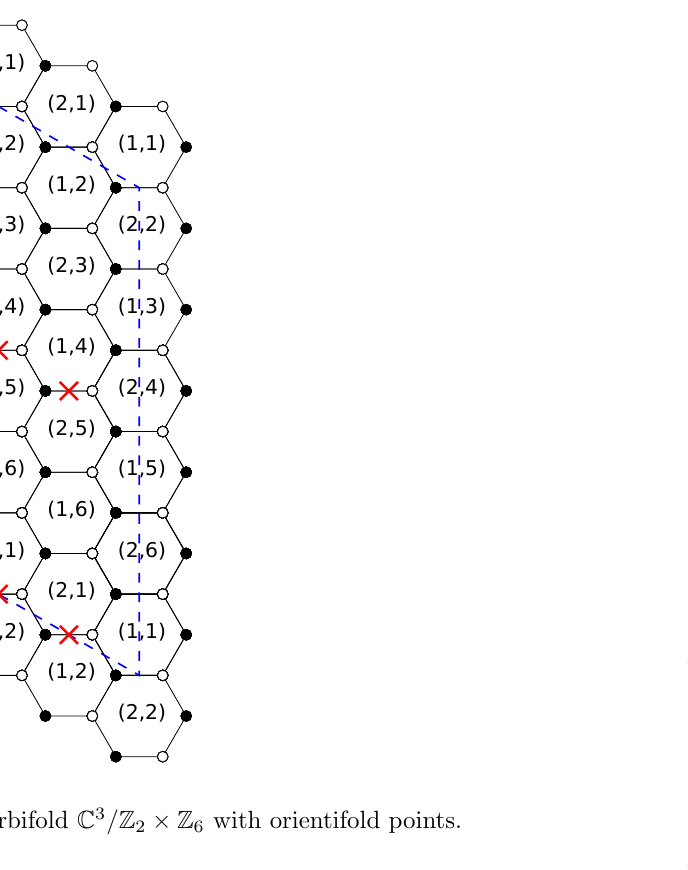
Figure 18 . The dimer of the orbifold C 3 = Z